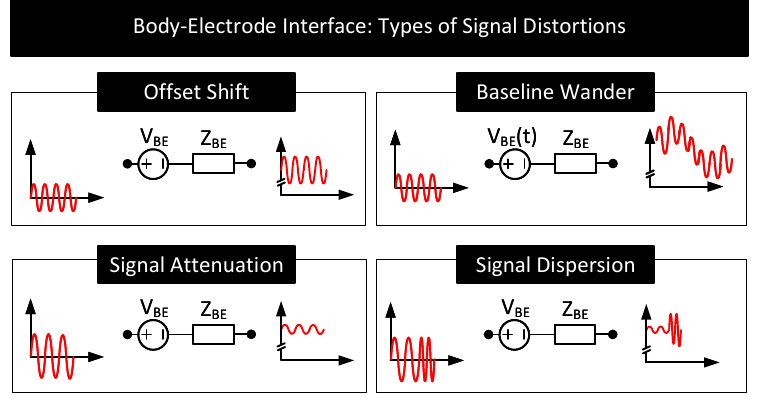
Figure 7. Types of distortions experienced by a signal passing through the body–electrode interface. A voltage source, V BE , in series with the impedance, Z BE , models the